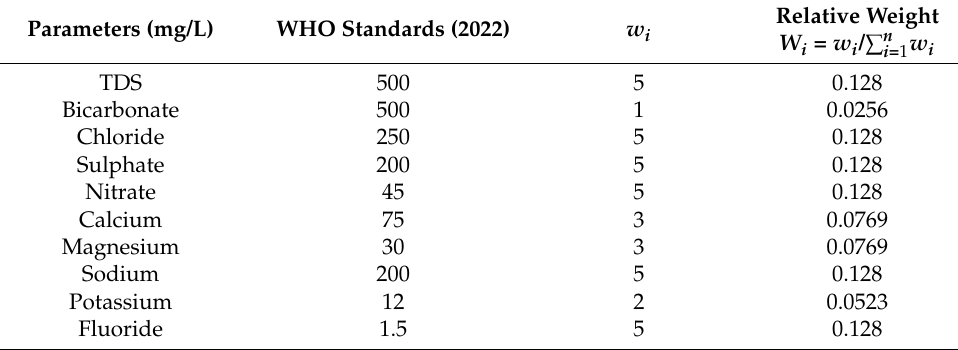
Table 1. Relative weights of chemical